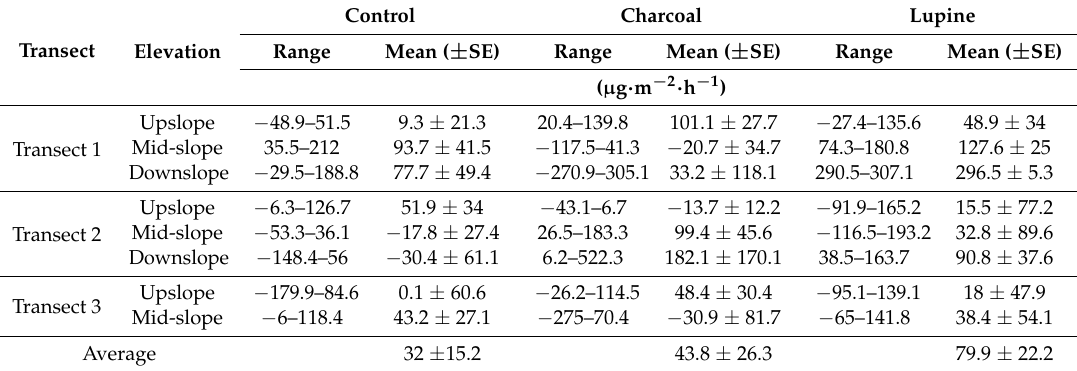
Figure 4. Distribution of observed nitrous oxide emissions from 24 static chambers based on combined data from all campaigns in 2013. Table 2. Summary, range (minimum and maximum) and mean ± standard error of means, of nitrous oxide (N 2 O-N) emissions based on combined data from all campaigns.